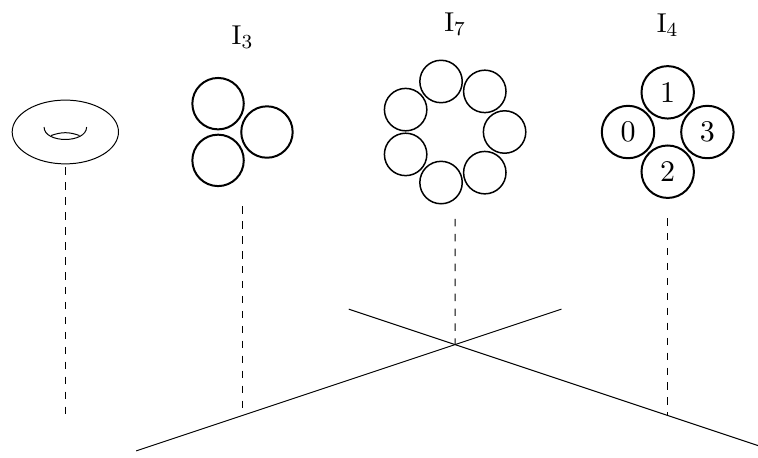
Figure 1 . From left to right: a generic point in the base B carries an elliptic fiber. It degenerates to an I 3 fiber at the location of a holomorphic curve in B . The fiber degenerates further to an I 7 fiber at a point of intersection with another curve in B carrying an I 4 fiber. The split I 4 fiber is comprised of four rational curves F i with index i taking values from 0 to 3. F i moving over the base P 1 gives rise to a Hirzebruch surface S i with some blow-ups, three out of which come from collision with the I 3 fiber on the adjacent curve adjoining three extra rational curves to S i